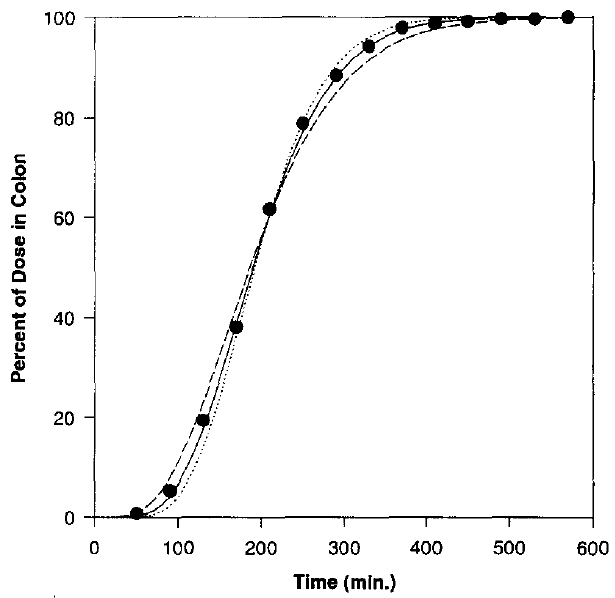
Figure 7. Estimate of human small intestinal transit flow using compartmental models. Reprinted with permission from Ref. [38]. 1996, Elsevier. _ _ _ five compartments; ____ seven compart- ments; …… nine compartments; ● ● ● cumulative percentage.